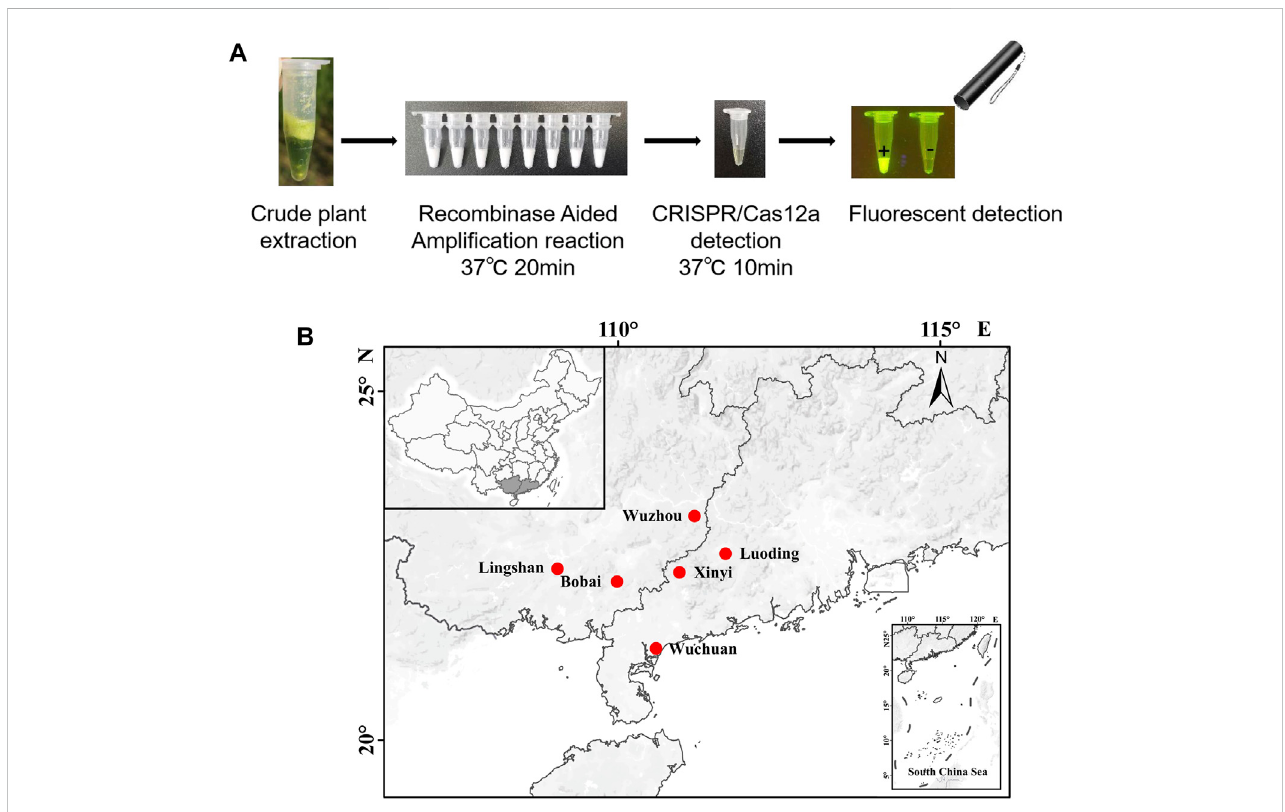
FIGURE 5 Fieldon-sitedetectionofSrMVandRSMVbytheRT-RAA-CRISPR/Cas12asystem. (A) Thepipelineofon-siteplantvirusdetection basedontheRT-RAA- CRISPR/Cas12a system. Take a piece of leaf from the plants and put it into a 1.5 ml tube, followed by grinding with 400 μ l crude extraction buffer. Then take 2 μ l crude extract into 25 μ l RT-RAA reaction system, water bath at 37 ° C for 20 min. Finally take 2 μ l RT-RAA products into 18 μ l CRISPR/Cas12a detection solution, water bath at 37 ° C for 10 min and observed under a UV fl ashlight. (B) The sites we performed the on-site detection of SrMV and RSMV in Guangdong and Guangxi province, China.